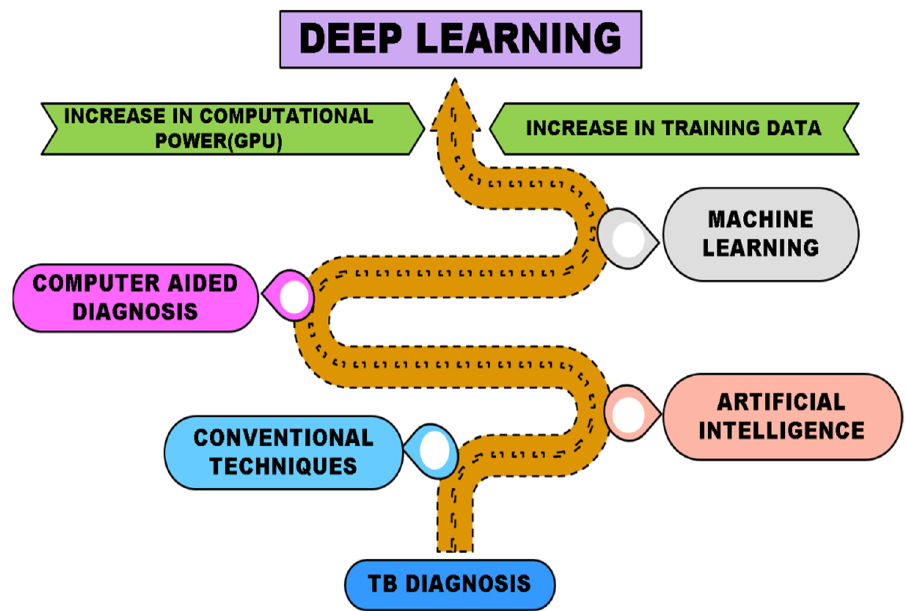
Figure 3. Evolution of artificial intelligence in TB diagnosis.